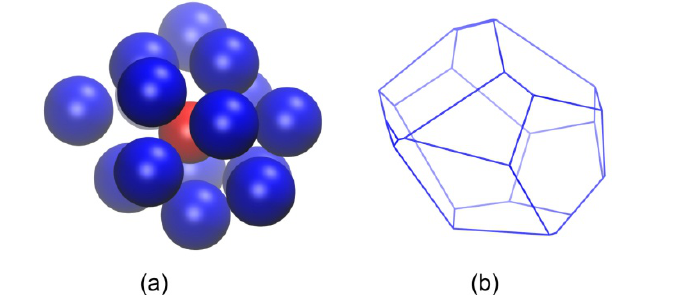
Figure 9. System visualizations showing: ( a ) a reference hard sphere and the nearest Voronoi neighbors; ( b ) the corresponding Voronoi polyhedron. The local environment of the reference sphere is predominantly amorphous ( , ). Global shape measures for the Voronoi cell: asphericity , acylindricity and relative shape anisotropy